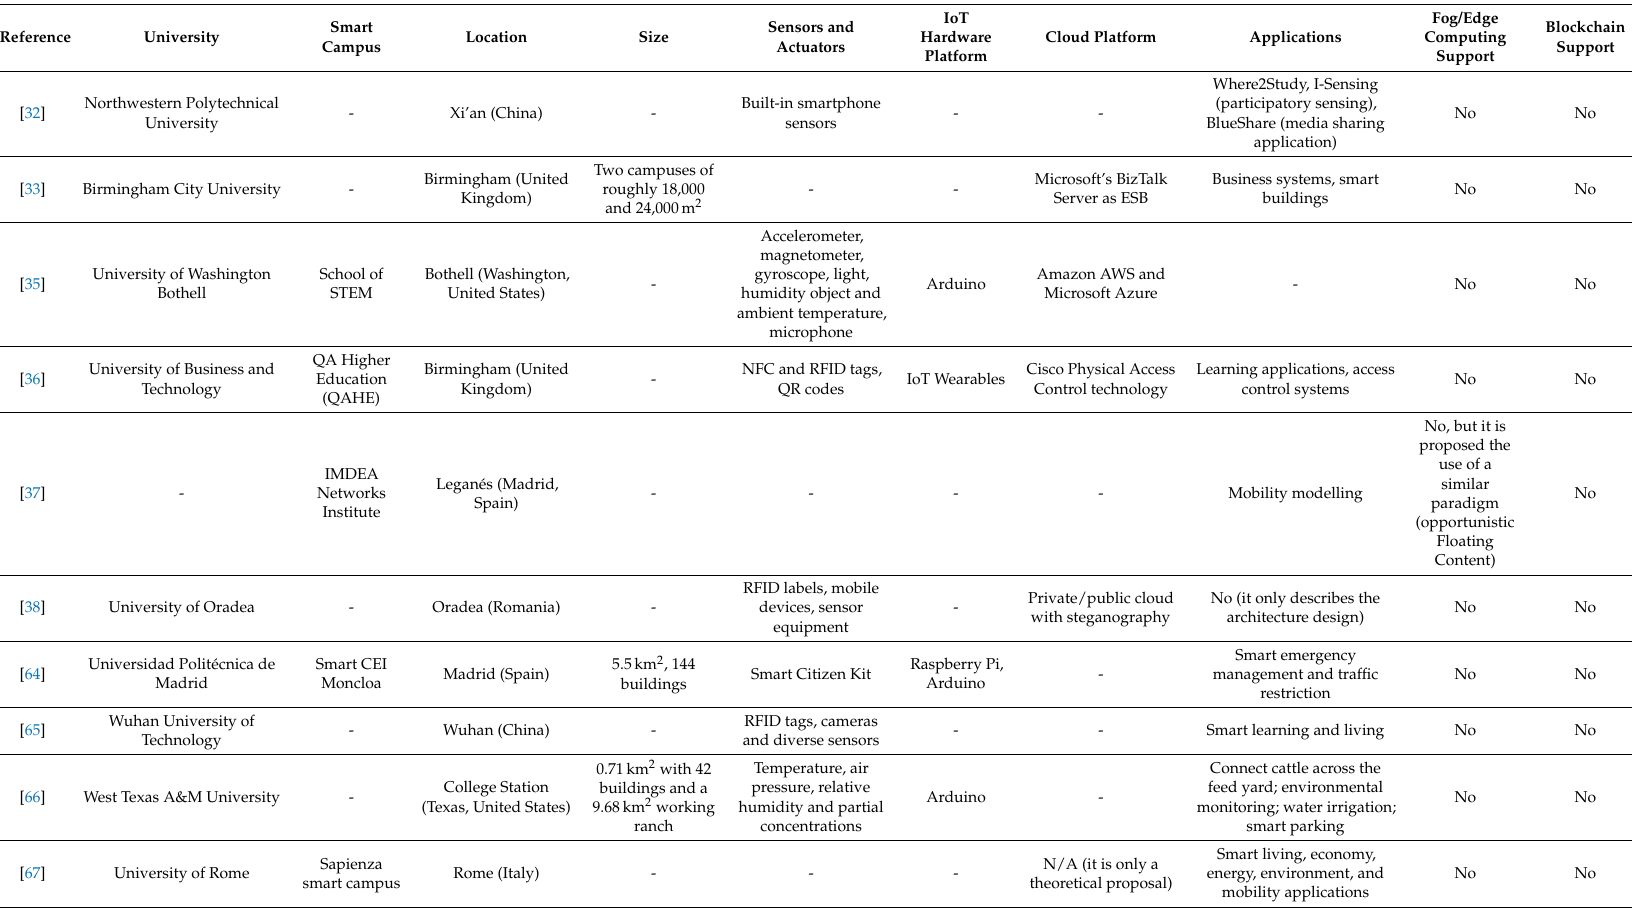
Table 1. Characteristics of the most relevant smart campuses